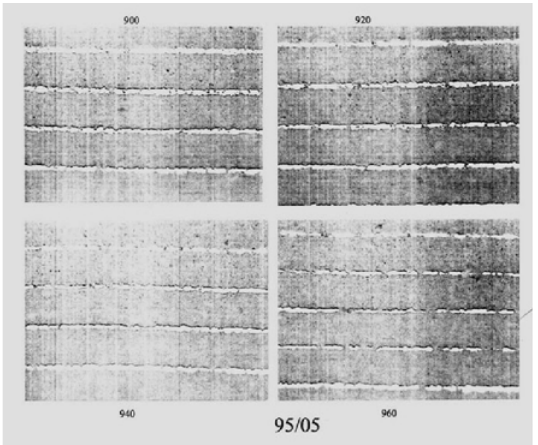
FIGURE 7 Capacitor layers produced with a 95:5 Ag = Pd powder.